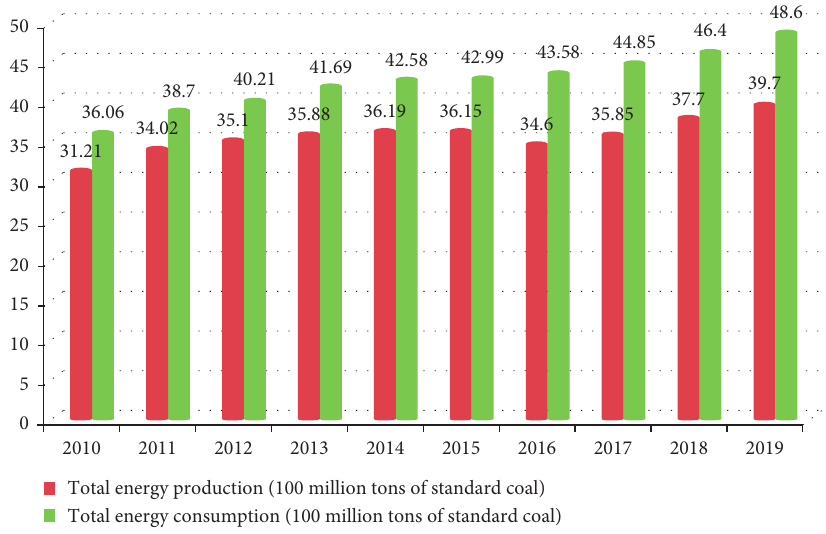
Figure 1: The total energy production and consumption from 2010 to 2019 in